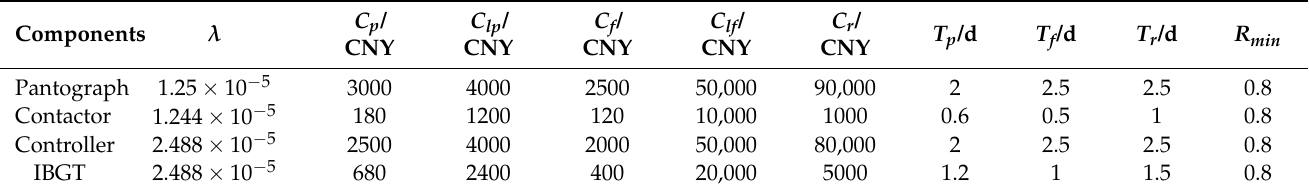
Table 5. Component parameter.